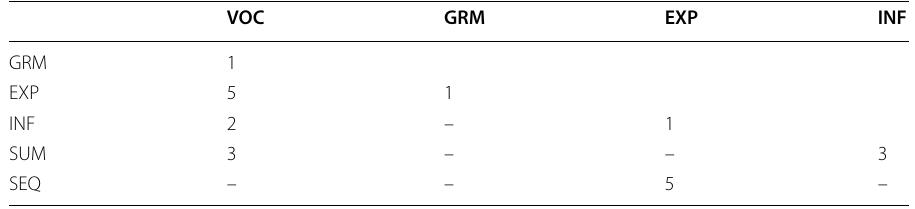
Table 7 Bivariate frequency of attributes in the final expert-defined Q -matrix VOC GRM